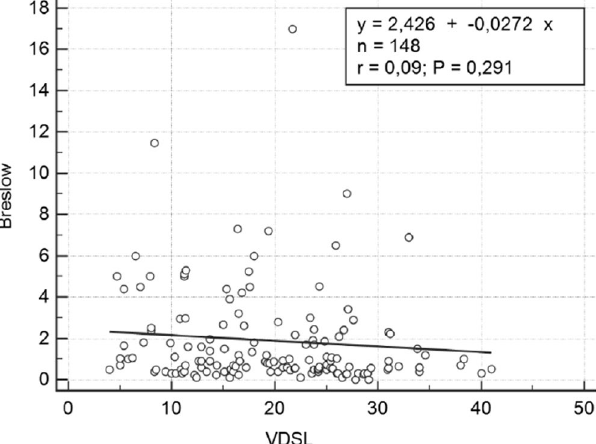
Figure 2. Linear regression between Breslow and VDSL (vitamin D serum levels). 148 subjects, p =